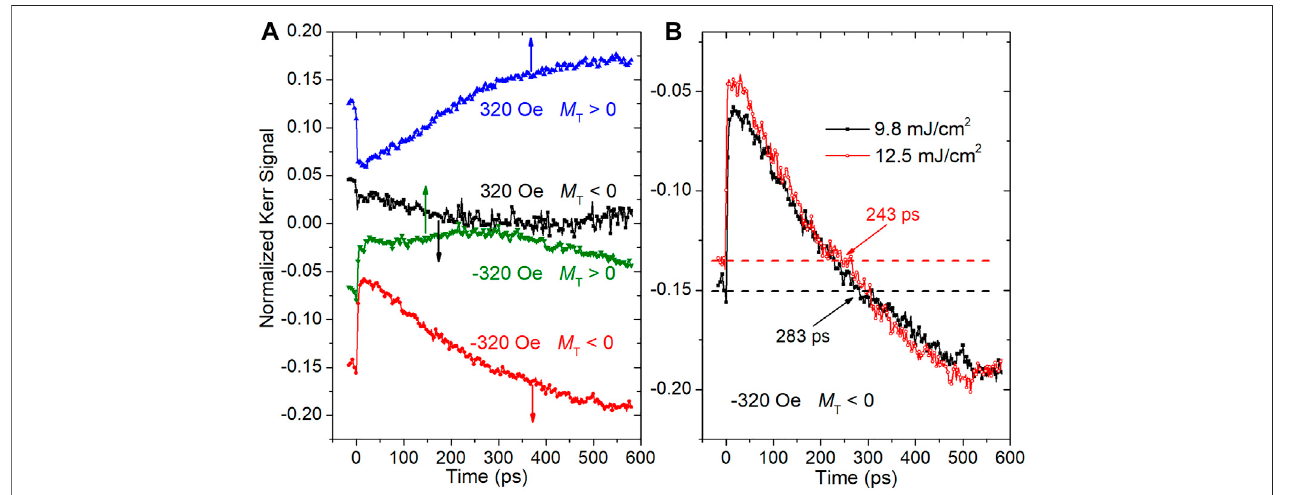
FIGURE 3 | (A) Laser-induced magnetization dynamics depended on the directions of exchange bias fi eld and external fi eld. The sign of M T shows the saturated state ofthe TbFeCo magnetization which re fl ects the direction of exchange bias fi eld. The arrows denote the direction of magnetization reorientation. (B) Comparison of magnetization dynamics measured under different excitation fl